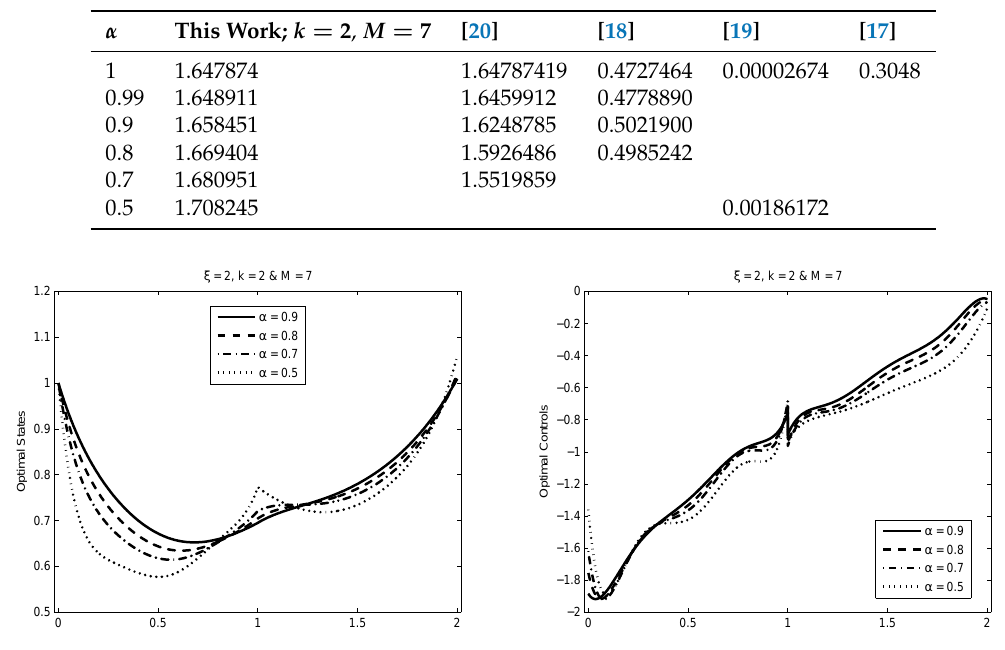
Figure 3. Optimal states and controls, Remark